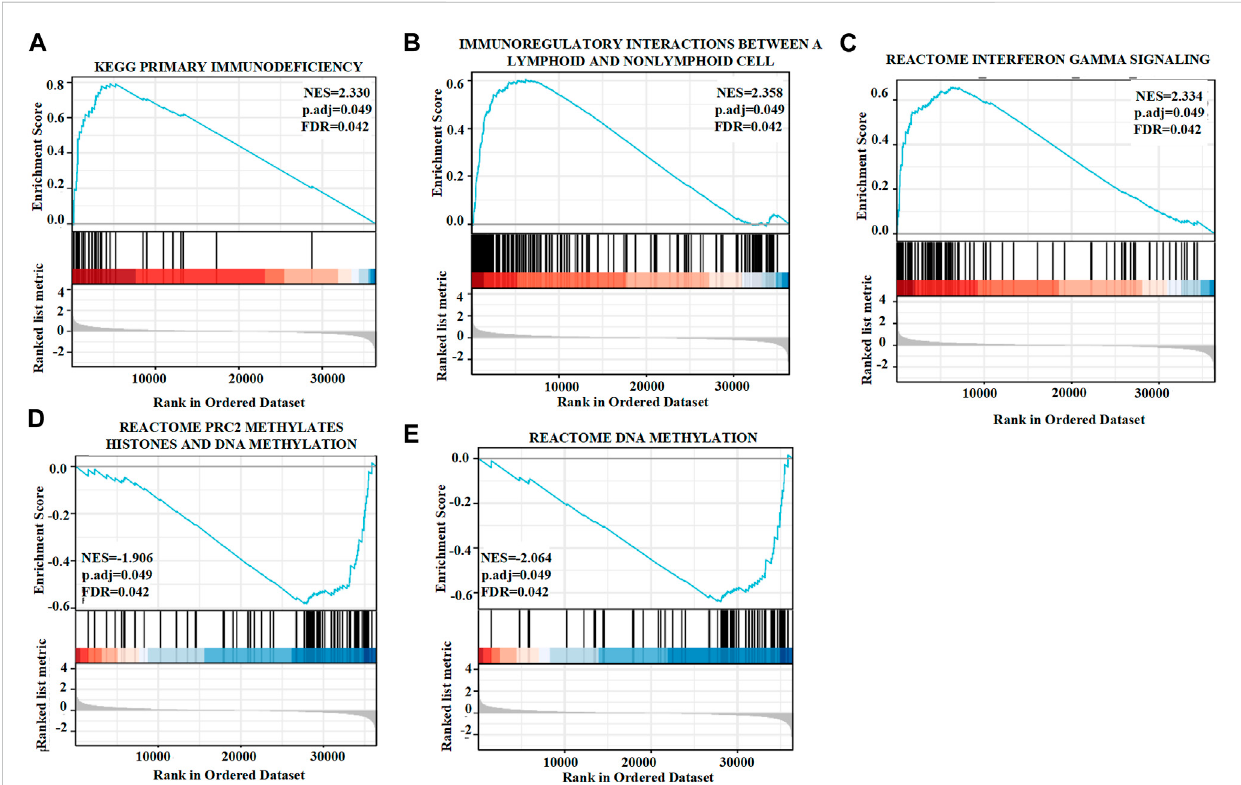
FIGURE 5 Enrichment plots from gene set enrichment analysis (GSEA). GSTK1 was differentially enriched in the setting of a primary immunode fi ciency (A) , immunoregulatoryinteractionsbetweenlymphoidandanon-lymphoidcells (B) ,interferongammasignaling (C) ,PRC2methylateshistones (D) ,andDNA methylation (E) . NES: normalized enrichment score; FDR: false discovery